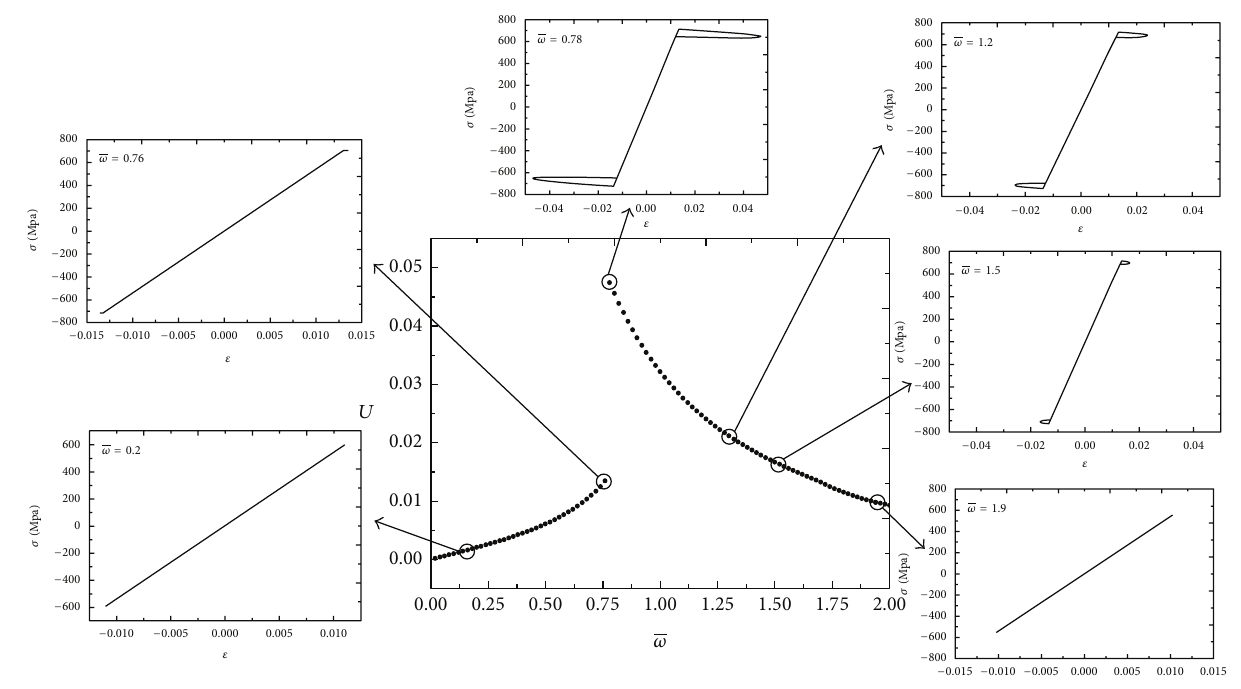
Figure 3: Up-sweep jumps with V = 0.025 m/s: comparison between frequency response and stress-strain curves.